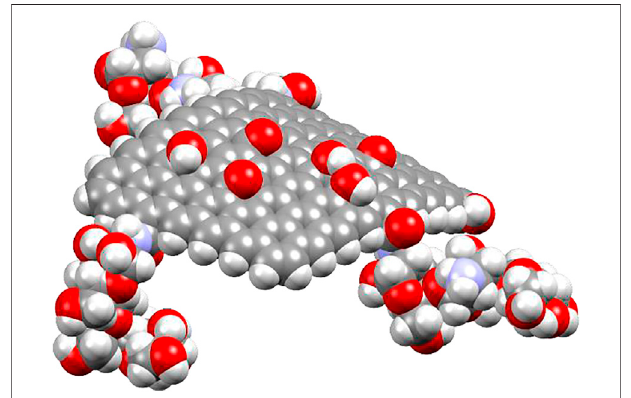
FIGURE 2 | FTIR spectra of GO (A) , CS (B) , and 3D GF-CS (C)